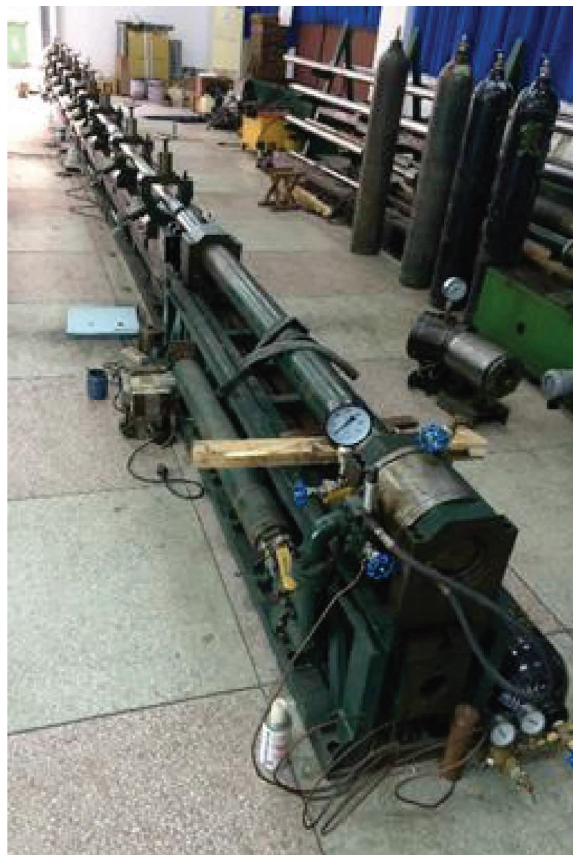
Figure 5: Components of the split Hopkinson pressure bar test system.